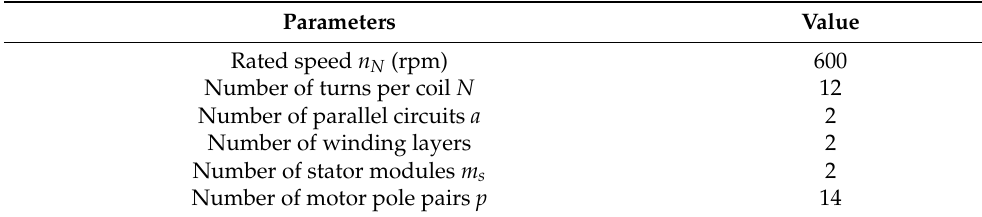
Table 1. Initial design dimensional parameters of the SCM-AFPM